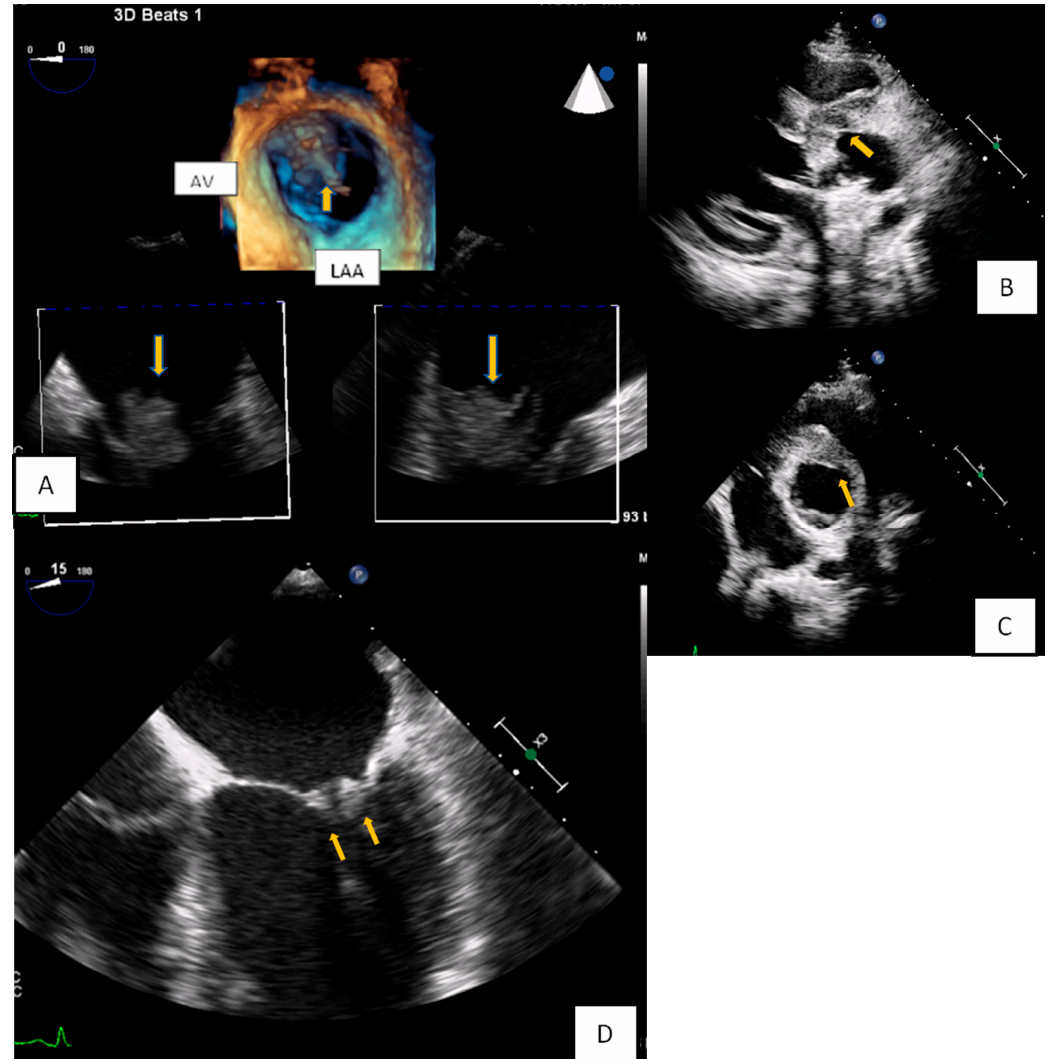
Figure 8. ( A ) 3D-TEE in a patient evaluated for a possible endocarditis. A large multilobular amorphous mass (vegetation) is found attached on the right commissure (3rd hour) of the anterior and posterior leaflet (AV: Aortic valve, LAA: Left atrial appendage). ( B , C ) A huge abscess infiltrating the aortic root and the aortomitral curtain in a young febrile patient with prosthetic aortic valve. ( D ) Transesophageal echocardiography-4 Chamber view. Increased thickness and echogenicity of both the tips of the leaflets in a patient with lupus erythromatosus